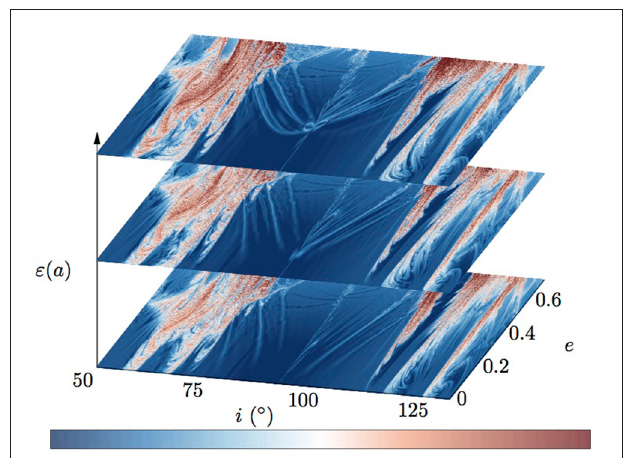
FIGURE 1 | A highly-resolved fence view of the stability of the prograde and retrograde regions obtained under the FLIs. The three slides depict the stability for a particular value of the non-linearity parameter ε ( a ) which depends on the secularly invariant semi-major axis. KAM tori correspond to white to light-red color, stable resonant orbits appear in blue while red colors correspond to chaotic orbits. The values ε ( a ) correspond to the three semi-major axis 18.6,22.6,24.6 10 3 km (the z-scale is only symbolic, in particular the { } × scale is not linear). This unscrewed view presents in a global, original and concise way the transition from order to chaos. See text for comments.